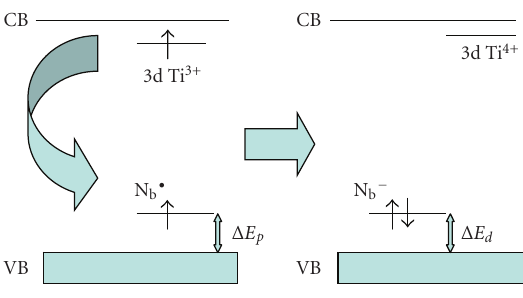
Figure 8: Electronic band structure changes from interactions be- tween N b • (N S • or N I • ) and Ti 3+ color centers. Reproduced